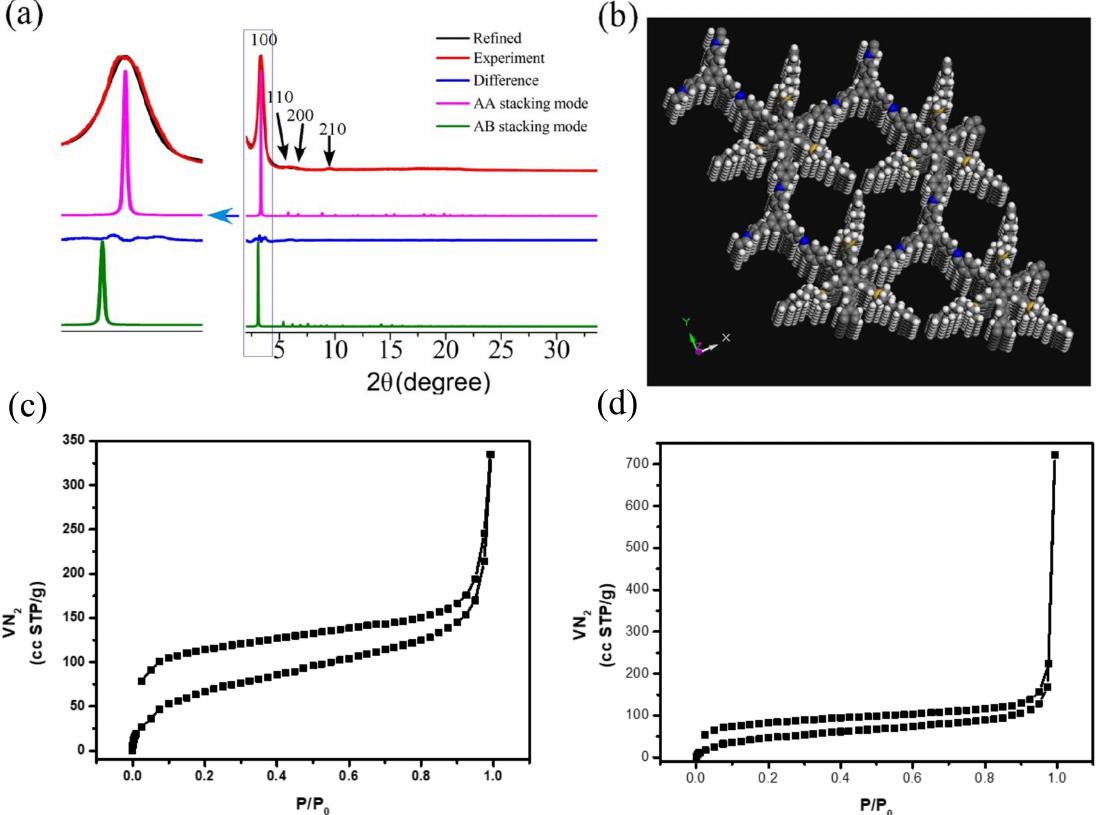
Figure 2. ( a ) Observed PXRD pattern (black curve, the major reflections are assigned) and Pawley refined profile (red curve) (Pawley refinements gave optimized parameters (a = b = 36.40 Å and c = 9.21 Å)), which provided good agreement factors (Rp = 6.46% and Rwp = 8.98%). Difference plot between the observed and refined PXRD patterns (blue curve). Simulated PXRD pattern for AA stacking (eclipsed structure) (pink curve) and AB stacking (green curve) of BHU-1. ( b ) Eclipsed structure of BHU-1 with the unit cell axis indicated. The alkyl chains are fully expanded to just show that they can reach each other for metathesis reaction to happen, but they can also coil within the channels. ( c ) Nitrogen adsorption–desorption isotherms of BHU-1 and ( d )